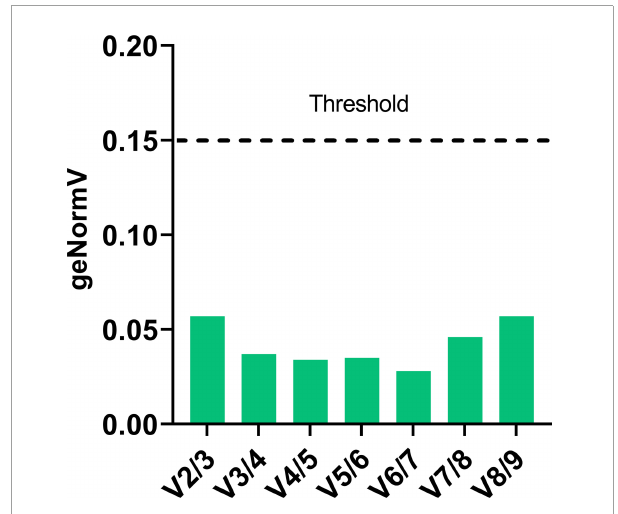
FIGURE4 Optimal number of reference genes for normalization in S. oryzae at various developmental stages. The pairwise variation values obtained from GeNorm analyses were used to determine the minimum number of reference genes for normalization. The value of Vn/Vn + 1 < 0.15 indicates that the minimum number of reference genes to be used for qPCR data normalization is